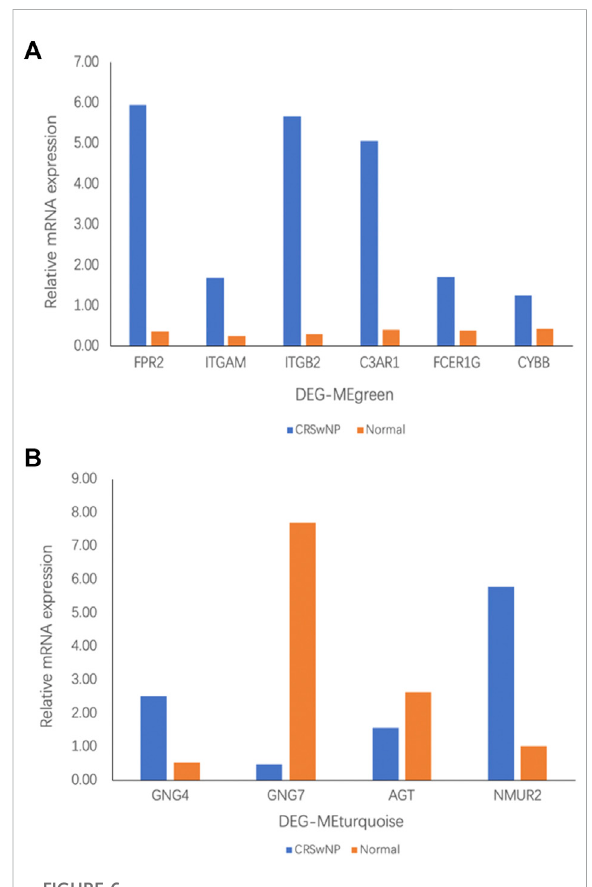
FIGURE 6 The mRNA expression in participants with CRSwNP ( n = 8) and normal controls ( n = 8) was assessed by qRT-PCR analysis. Fold change was calculated relative to normal controls. (A) mRNA expression in the DEG-MEgreen module. (B) mRNA expression in the DEG-MEturquoise module. All data are displayed as the mean, and n = 8 per